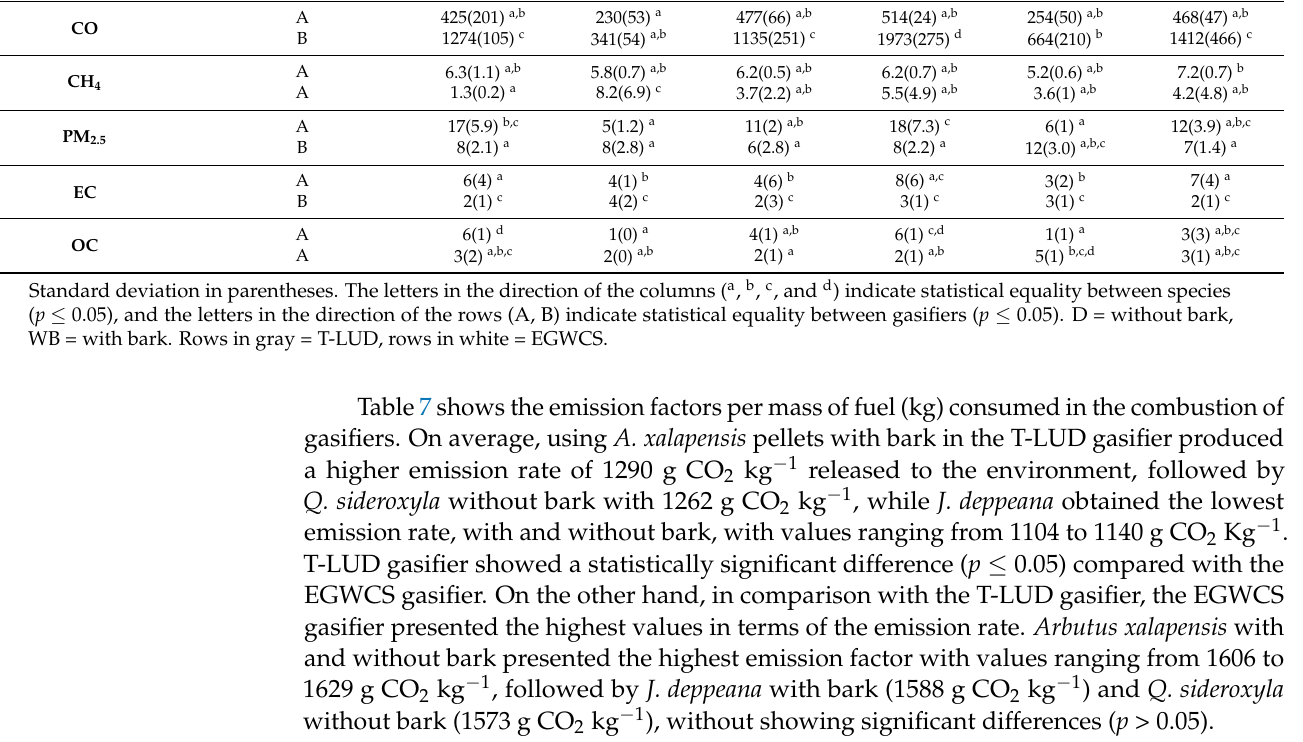
Table 7. Average emission factors per mass of fuel consumed.